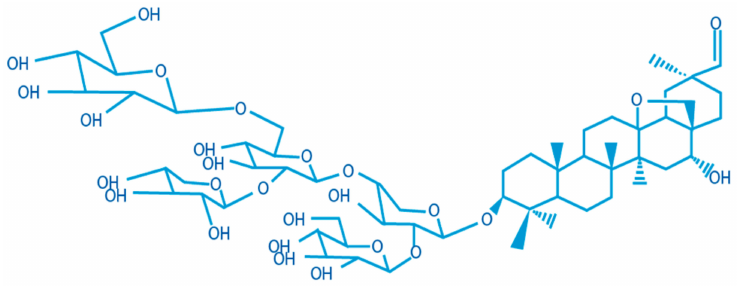
Figure 1. Cyclamen saponin G